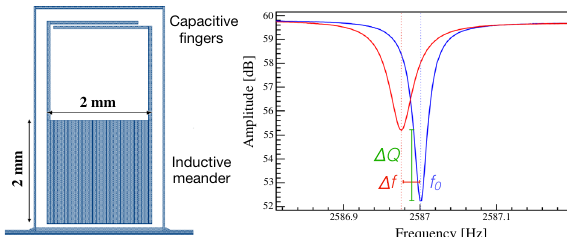
Fig. 1 Left: KID geometry developed in CALDER. The meandered inductor ( L ) (30 strips of 62 . 5 µ m × 2 mm separated by a gap of 5 µ m) has an active area of around 4 mm 2 , is closed on a 2-finger capacitor ( C ) on one side, and coupled to a coplanar wave guide (CPW) on the other side. A ground line surrounds the LC circuit for electro- magnetic isolation; Right: Frequency scan of a KID. When energy is absorbed in the inductor, the resonant frequency f 0 and quality factor Q of the resonator are reduced. When the KID is biased on-resonance at fixed readout frequency, the signal is detected as phase and amplitude modulations of the wave transmitted past the device